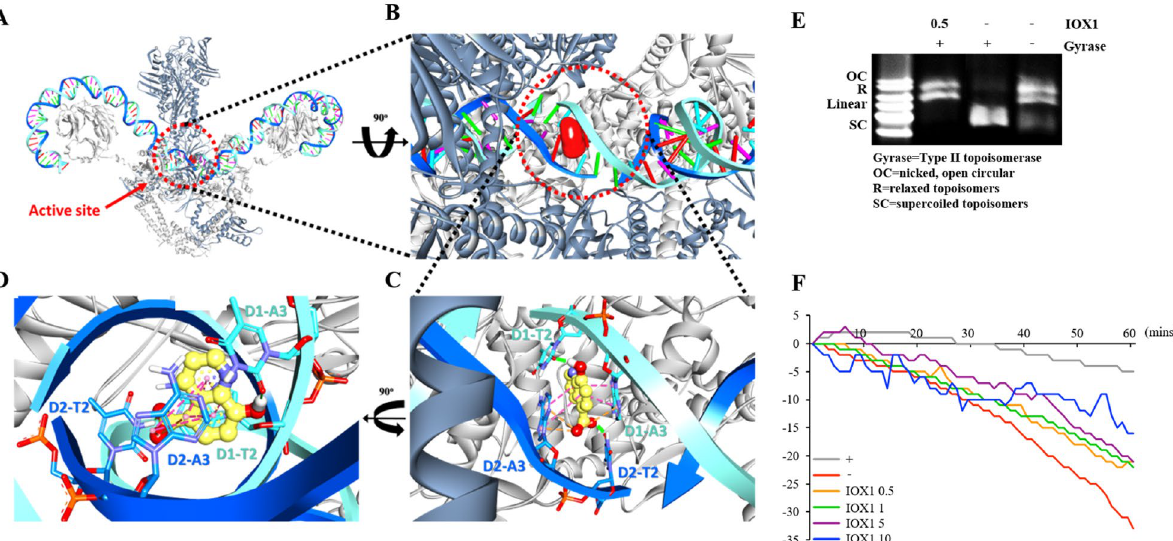
Figure 6. Mode of action of IOX1 as an antibiotic against bacteria. ( A ) Front views of the 3D structure of E. coli DNA gyrase. DNA chains 1 and 2 are shown in cyan and blue, and subunits A and B are shown in gray and dark gray, respectively. The active site is shown in the red cycle, and the IOX1 surface is shown in red. ( B ) Close-up view of the active site of E. coli DNA gyrase after 90° rotation for a better view. ( C ) Close-up view of the active site in E. coli DNA gyrase. The stick models of IOX1, DNA chain 1 and DNA chain 2 are shown in yellow, cyan, and blue, respectively. Hydrogen bond, hydrophobic, and electrostatic interactions are shown as green, pink, and orange, respectively. ( D ) Close-up view after 90° rotation showing a different angle view. ( E ) The mobility of supercoiled bacterial DNA following IOX1 treatment processed by relative quantitation via ImageJ software. ( F ) Enzymatic evaluation of ATPase activity of E. coli DNA gyrase in the presence of IOX1 from 0.5 to 10 μM compared with that of the negative control (no enzyme) and the positive control (no